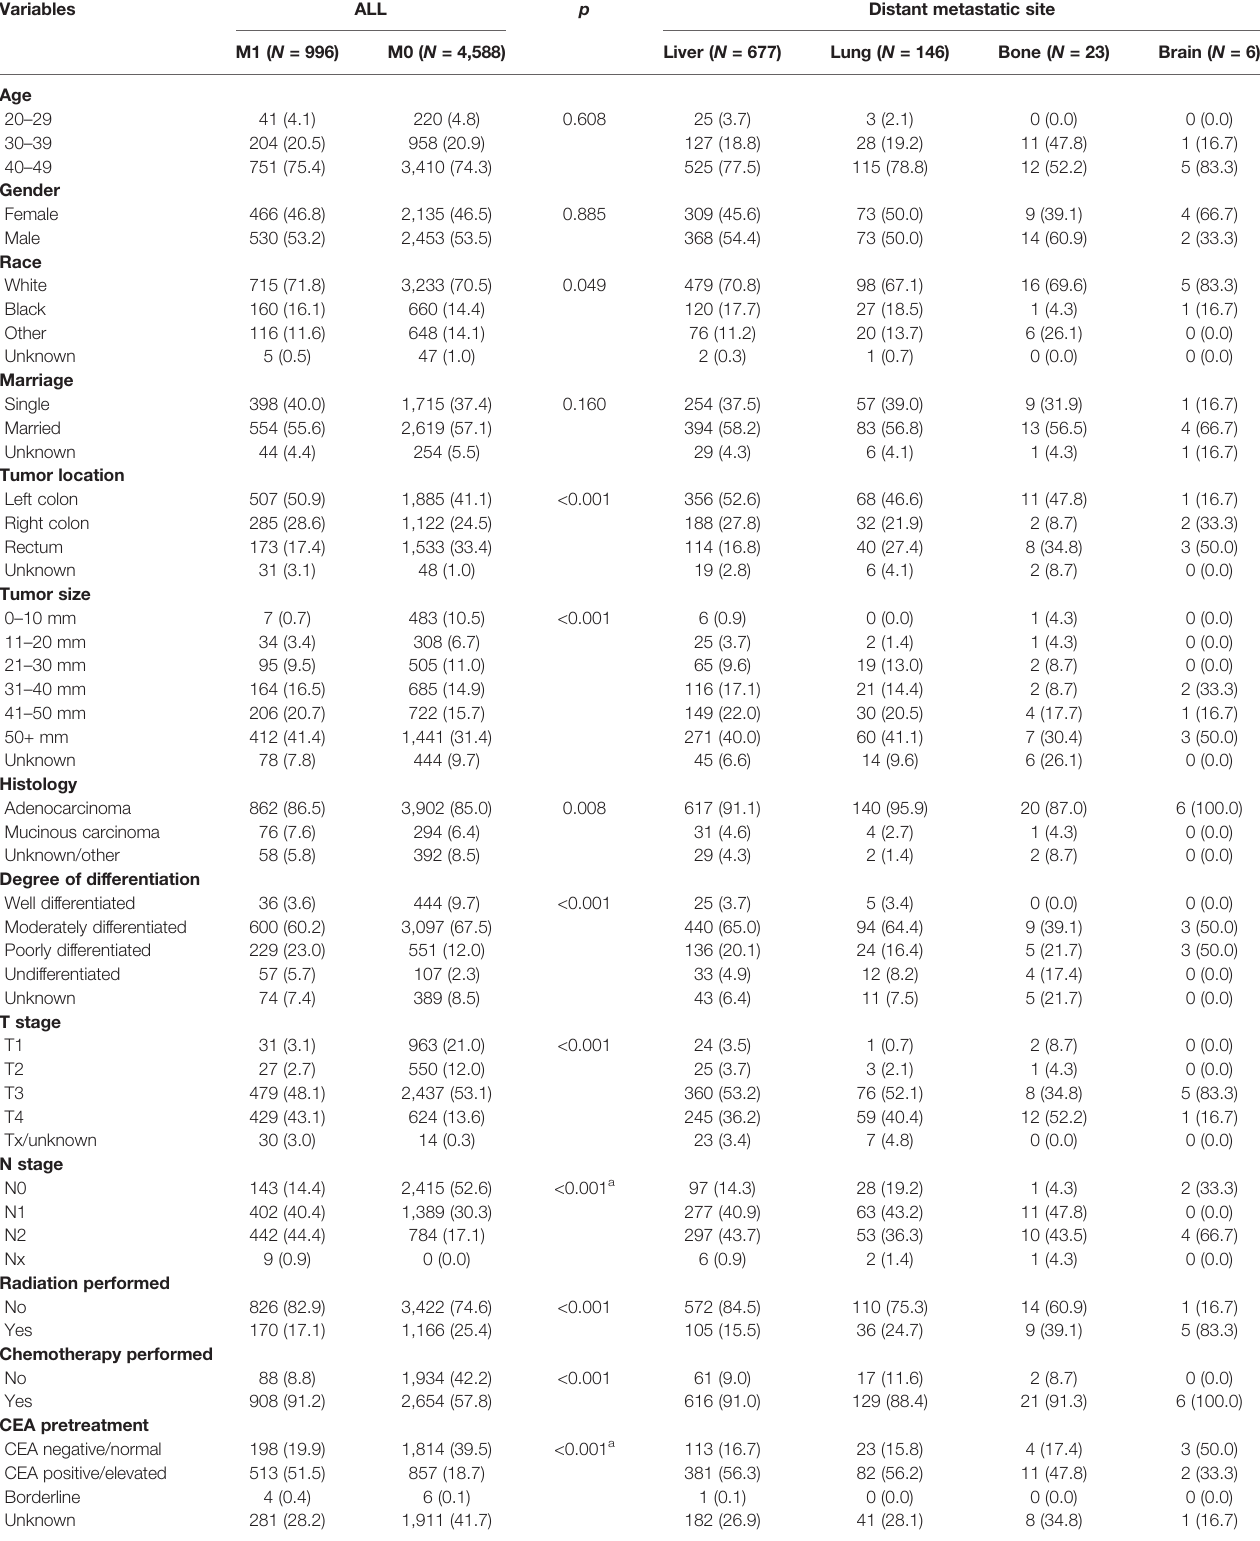
TABLE 1 | Clinicopathological characteristics of young-onset colorectal cancer by metastatic site in all including patients from the SEER database.